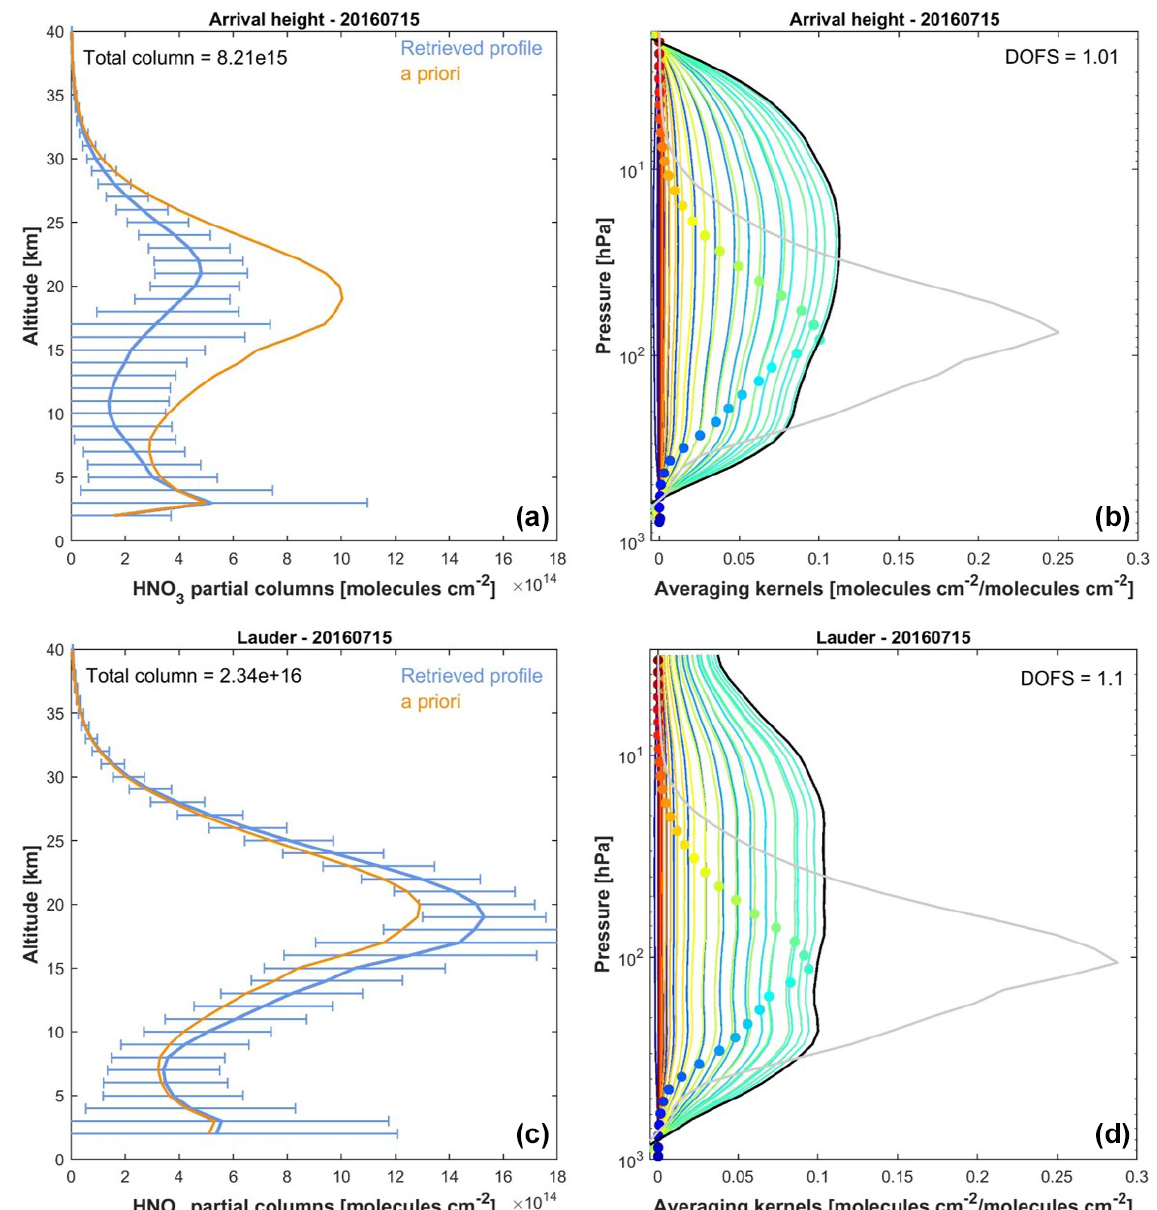
Figure 1. Examples of IASI HNO 3 vertical profiles (in molec . cm − 2 ) with corresponding averaging kernels (in molec . cm − 2 (molec . cm − 2 ) − 1 ; colored lines, with the altitude of each kernel represented by the colored dots) along with the to- tal column averaging kernels (black) and the sensitivity profiles (grey) (both divided by 10) above Arrival Heights (77.49 ◦ S, 166.39 ◦ E, a, b ) and Lauder (45.03 ◦ S, 169.40 ◦ E; c, d ). The error bars associated with the HNO 3 vertical profile represent the total retrieval error. The a priori profile is also represented. The total column and the DOFS values are